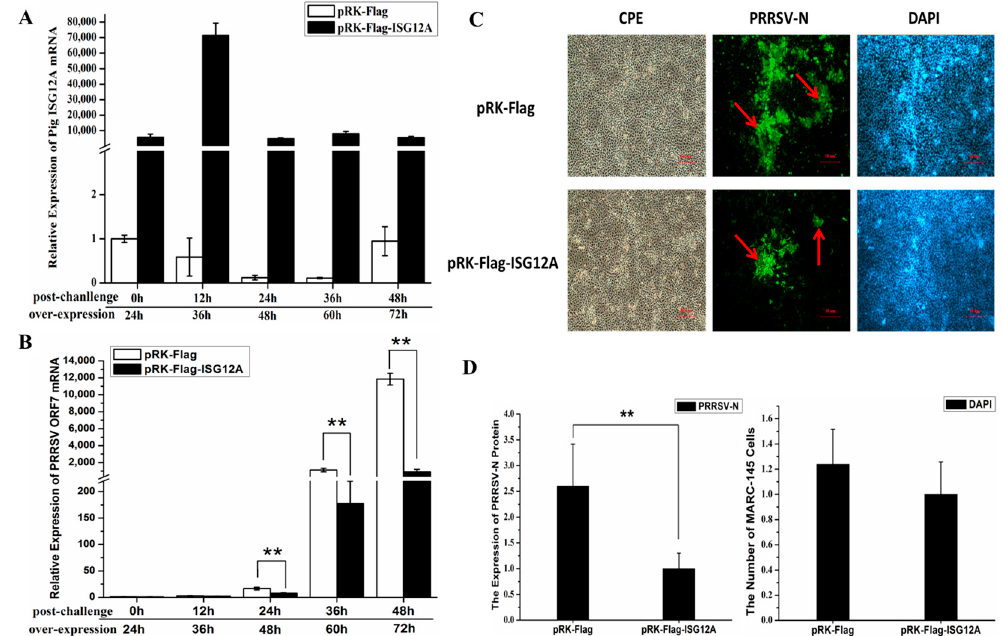
Figure 5. Ectopic expression of porcine ISG12A restricted PRRSV replication. The control vector (pRK-Flag) or pRK-Flag-ISG12A were transfected into MARC-145 cells, and PRRSV replication was assessed by expression of PRRSV ORF7 mRNA and PRRSV N protein. ( A ) The relative mRNA level of porcine ISG12A at 0, 12, 24, 36 and 48 hpc; ( B ) The relative mRNA level of PRRSV ORF7 at 0, 12, 24, 36 and 48 hpc; ( C ) Result of immunofluorescence assay. “CPE” indicates the observed cytopathic effects in the bright field, “PRRSV-N” represents the results of fluorescence-stained cells with the antibody against the PRRSV N protein (green marked by red arrows); “DAPI” represents the cell density by nuclear staining with DAPI (blue); scar bar = 10 µm; ( D ) The statistical results of the IFA and the number of fluorescence-positive cells were normalized to the total cell number (DAPI-stained cells) to evaluate the relative PRRSV level. Student’s t -test: ** p < 0.01.